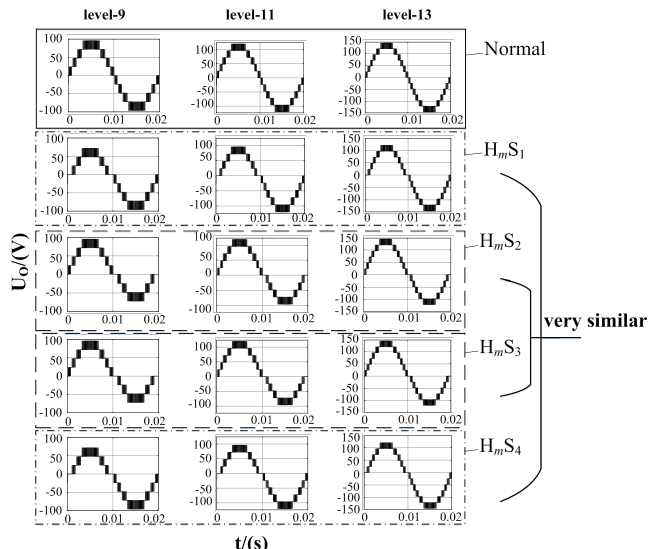
Figure 5. Fault signals in H_bottom of CHMI when m = 4, 5, 6 and load = 5 Ω